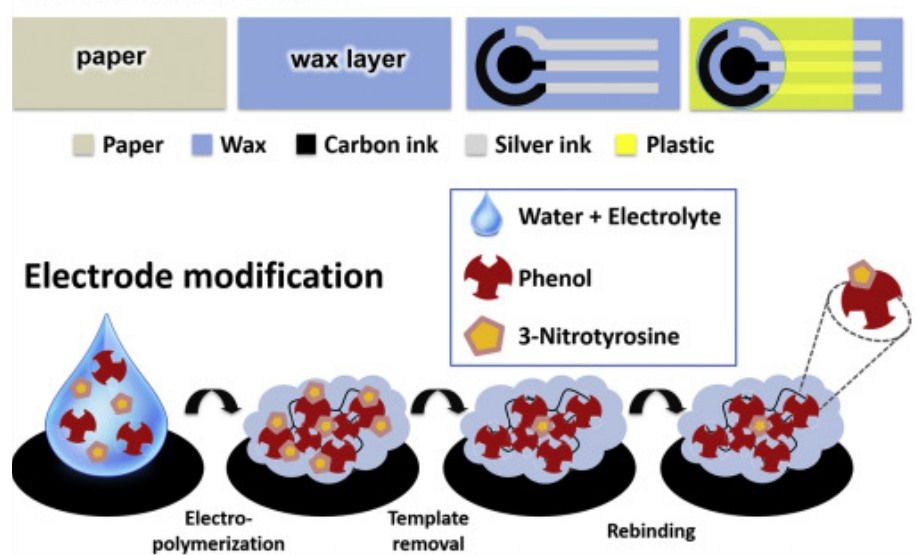
Figure 8. Schematic presentation of designing a paper ‐ sustained device for label ‐ free detection of 3 ‐ NT. Reprinted with permission from [116]. Copyright 2020 Elsevier. 3-NT. Reprinted with permission from [116]. Copyright 2020